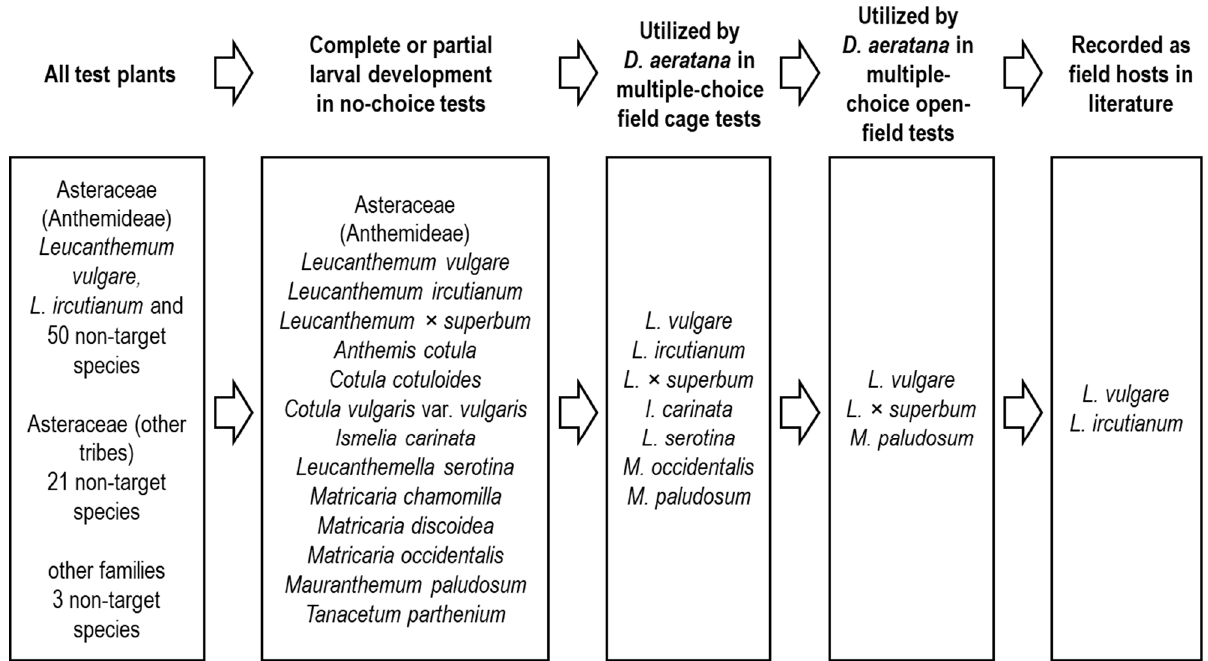
Figure 5. Summary of results of host-specificity tests with Dichrorampha aeratana . All plant species were first tested in no- choice larval development tests and all except one species ( Cotula vulgaris var. vulgaris ) that supported larval development in these tests were subsequently exposed to females in multiple-choice tests in field cages and under open-field conditions. Leucanthemum ircutianum was not tested under open-field condition.